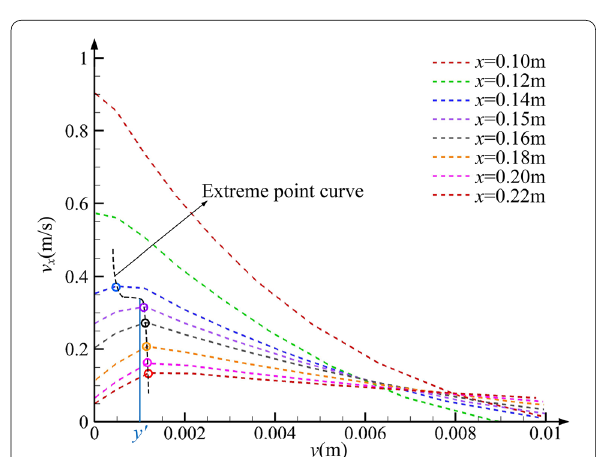
Figure 12 X -velocity status along the y -direction at different x positions